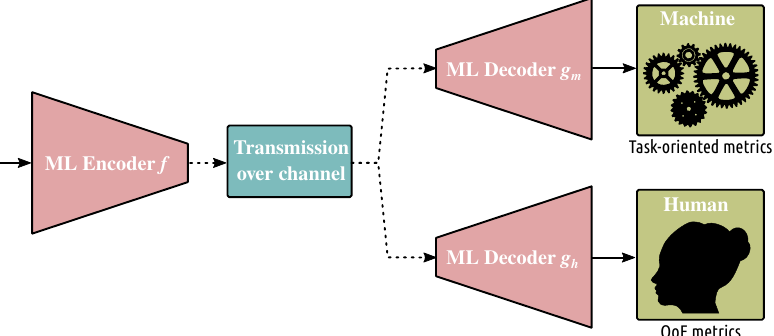
Figure 8. Compression aim changes since the decoded images or videos can be used to perform automatized tasks (e.g., identify dangerous situations in vehicular networks, recognize persons, etc.) apart from being watched by humans. This necessitates the consideration of different metrics for defining the loss functions of the neural network